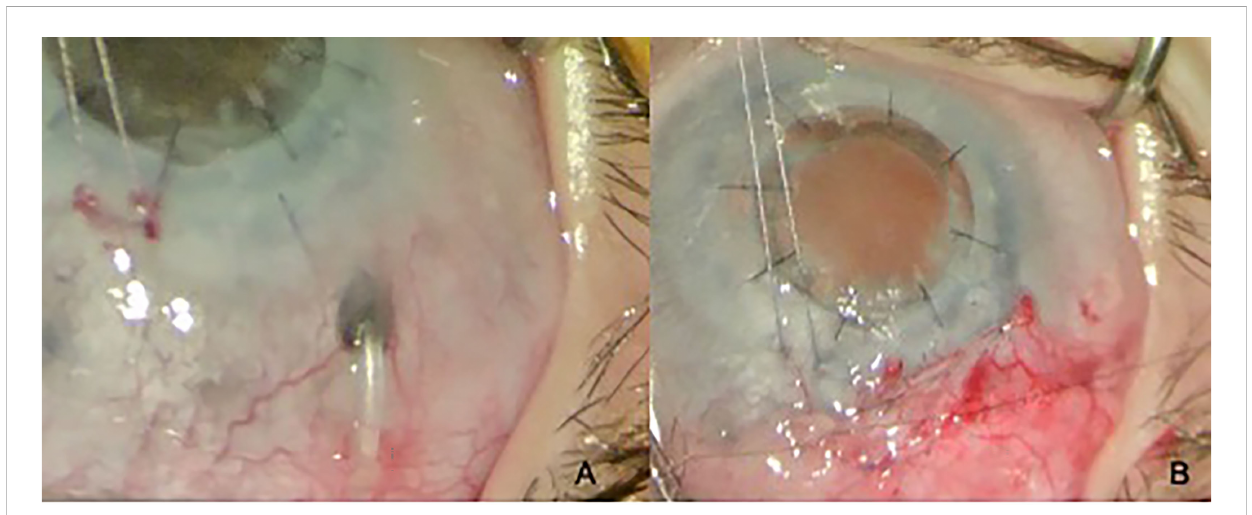
FIGURE 5 Tube exposure (A) and its closure (B) in a 2-year-old child with PCG and a history of penetrating